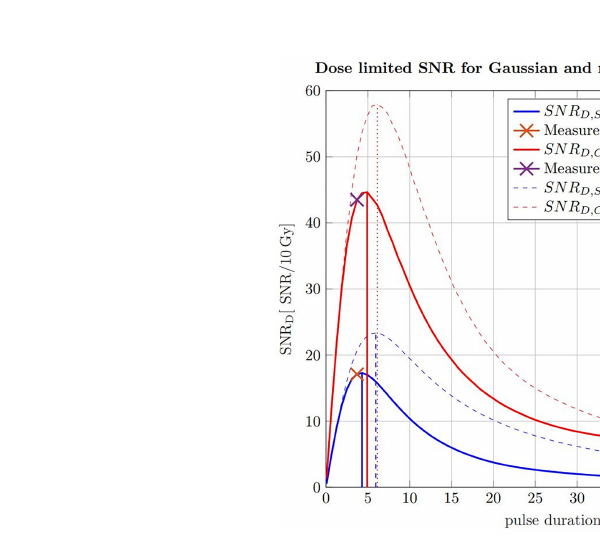
FIGURE 12 Simulated SNR D of raw ionoacoustic signals for Gaussian (solid) and rectangular (dashed) in blue and their corresponding correlations in red. The measurement analysis done by Lehrack et al. (15) is shown by the orange cross and the corresponding correlation evaluation by the purple cross. Additionally, the maximum position, which indicate the ideal pulse durations are marked by the vertical